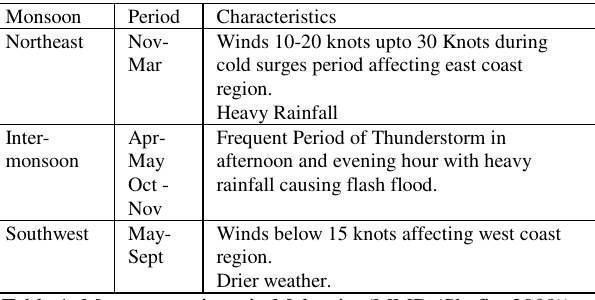
Table 1. Monsoon regimes in Malaysia. (MMD,(Shafie, 2009)).